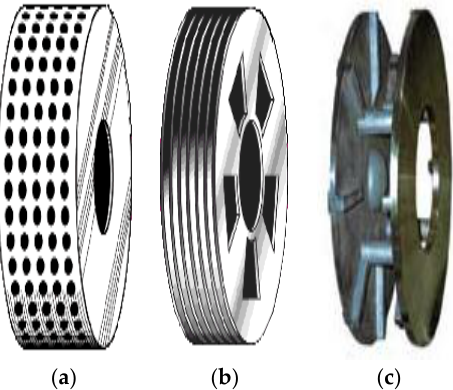
Figure 1. Evolution of disc pump impeller concepts. Flow enters from the right parallel to the rotational axis. ( a ) Rotating cylinder with holes. ( b ) Tesla disc pack (without radial blades). ( c ) Bladed disk pump (radial blades with large gap).